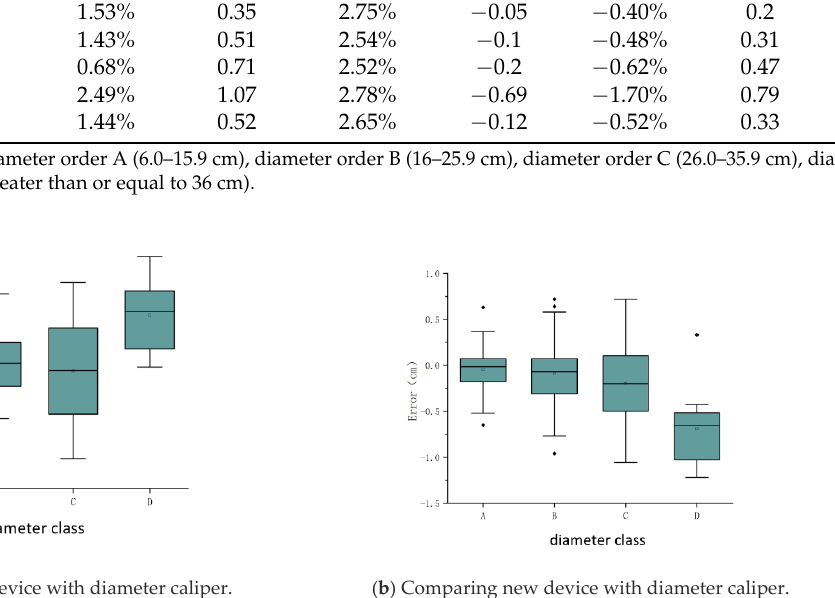
Figure 10. Distribution of DBH error among different diameter orders.